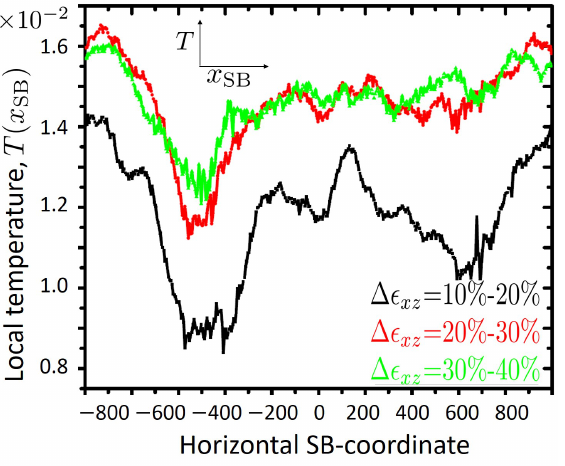
Figure 3. Temperature versus x SB (see Figure 2), evaluated for three different shear strain intervals as indicated. The horizontal SB-coordinate is obtained as the x -component of the geometric center of particles within a slab of thickness ∆ x = 5 which belong to the shear band. It essentially coincides with the midpoint of the slab. Temperature is obtained from the average kinetic energy of those particles which are considered when calculating x SB . Each curve shown here represents an average over ten calculations, performed for small strain intervals of [ (cid:101) xz , (cid:101) xz + 1% ] , [ (cid:101) xz + 1%, (cid:101) xz + 2% ] , ...,